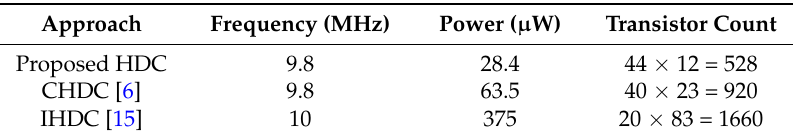
Table 1. Power and area comparisons with different delay cells.